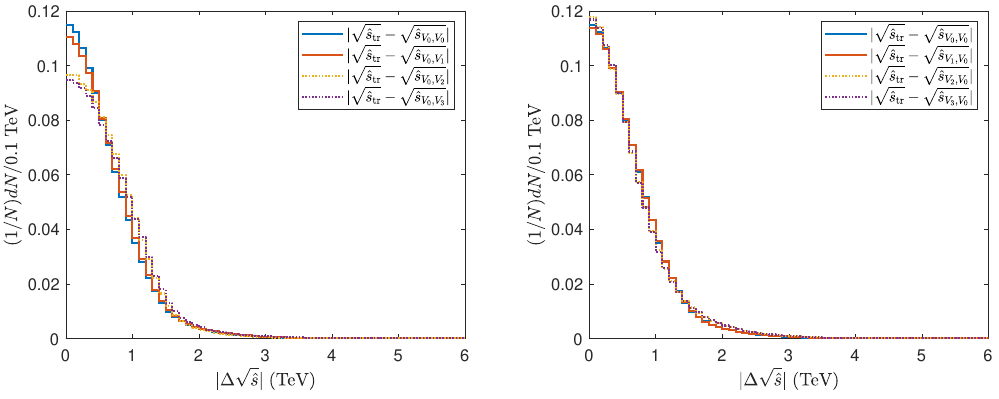
√ ˆ s | for ˆ s V and ˆ s V . Note that ˆ s V 0 ,V i i ,V 0